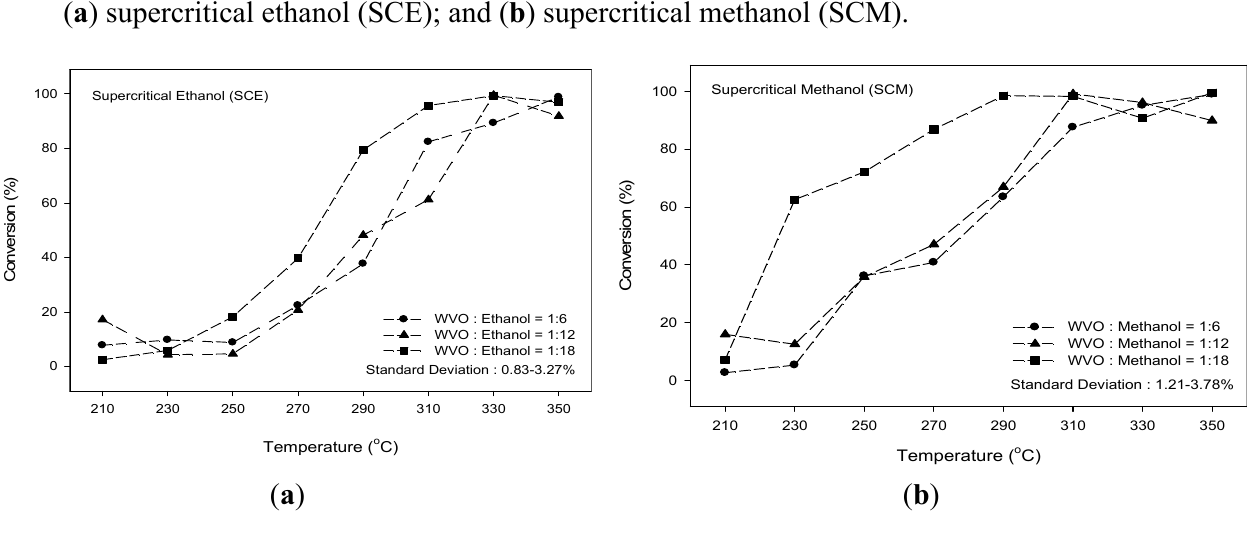
Figure 2. Conversion of waste vegetable oil (WVO) to alkyl esters in supercritical alcohols: